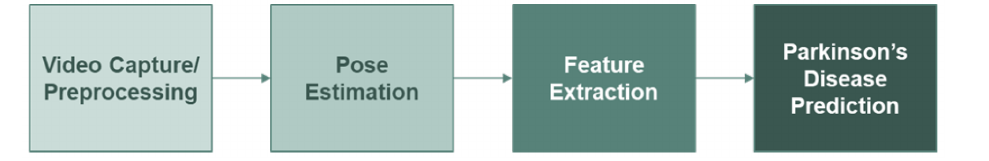
Figure 1. Overall methodology, showing the processes from video capture, human pose estimation, feature extraction, and PD prediction.